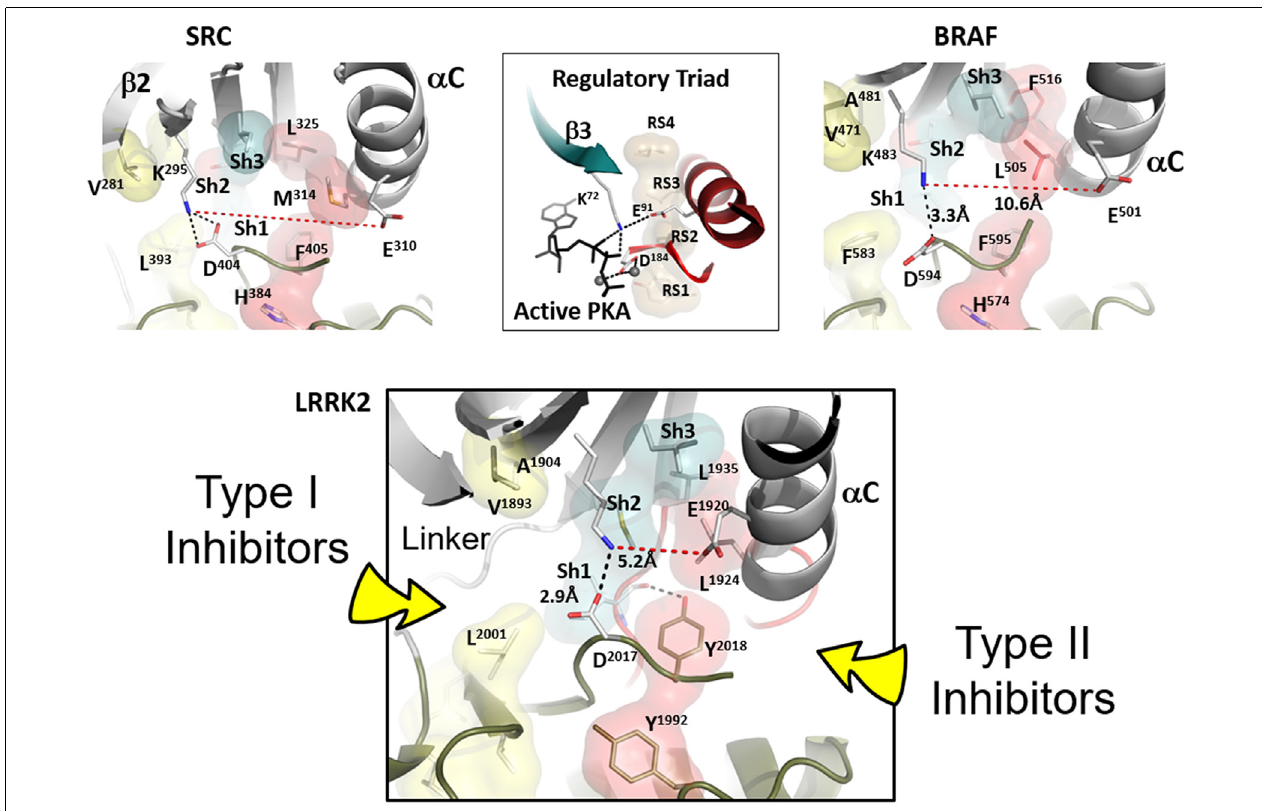
FIGURE 2 | Confirmation of Inactive LRRK2 is compared to inactive BRaf and Src. The conformation of inactive LRRK2 as seen in the recent RCKW structure (Deniston et al., 2020) is at the bottom panel. For comparison, an inactive conformation of Src and BRaf are shown on the top panel with the shells of the R-spine residues in red and the Shell residues in teal. In the middle of the top panel is the active conformation of the regulatory triad of PKA when it is bound to ATP and Mg ions. The aligned R-spine in active PKA is indicated by beige shells. The bottom panel depicts LRRK2 in an inactive conformation (Deniston et al., 2020). The arrow on the left indicates type I protein kinase inhibitor specific interactions with the linker/hinge region, while the right arrow points to the deep pocket only accessible in the DFG “out” conformation. Type II protein kinase inhibitors protrude into this pocket to stabilize the DFG “out” conformation. Both inhibitor types are ATP competitive (Rohm et al.,